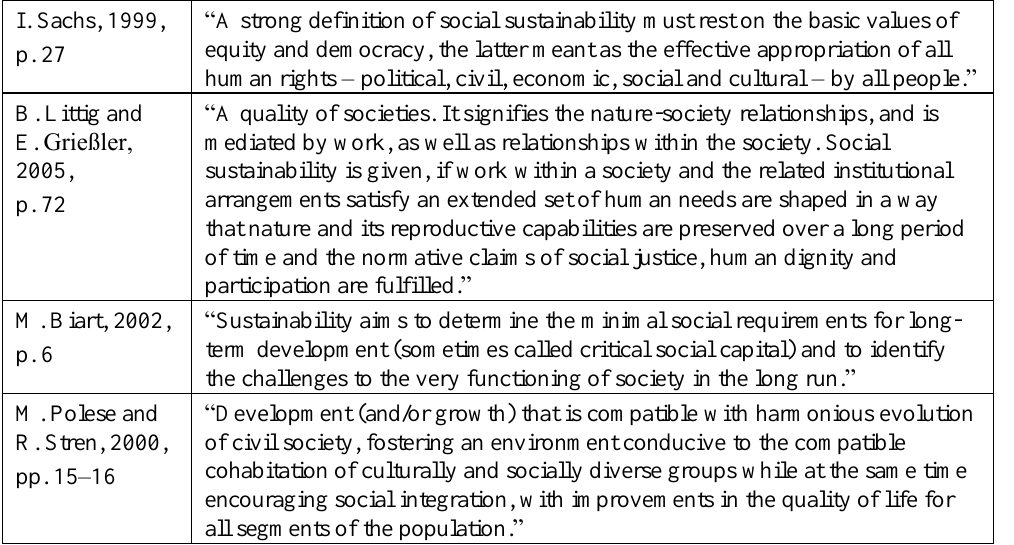
Table 1. Definitions of social sustainability (Colantonio, 2009)